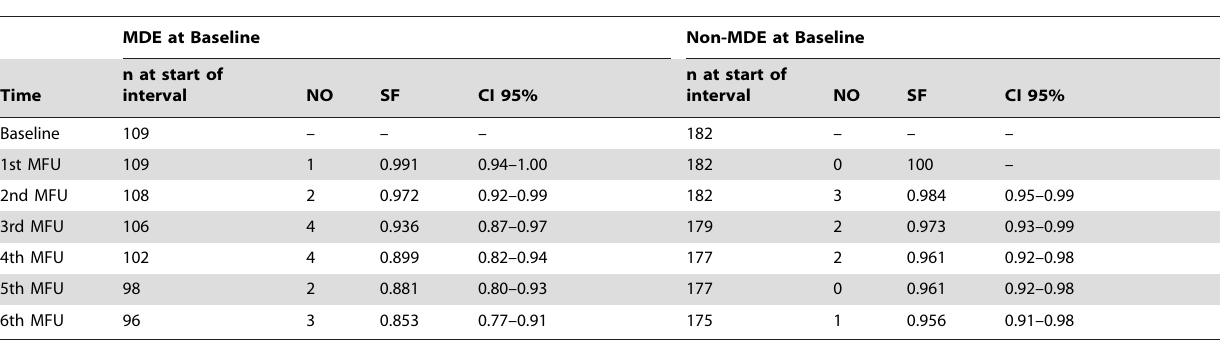
Table 4. Survivor Function (SF) and MDE at baseline (MDEb).